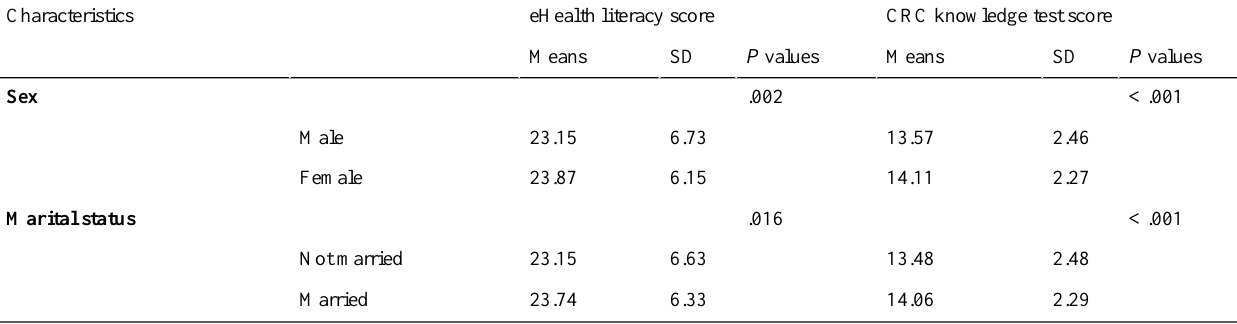
Table 2. Association of eHealth literacy and knowledge of CRC with sex and marital status (using the t test).